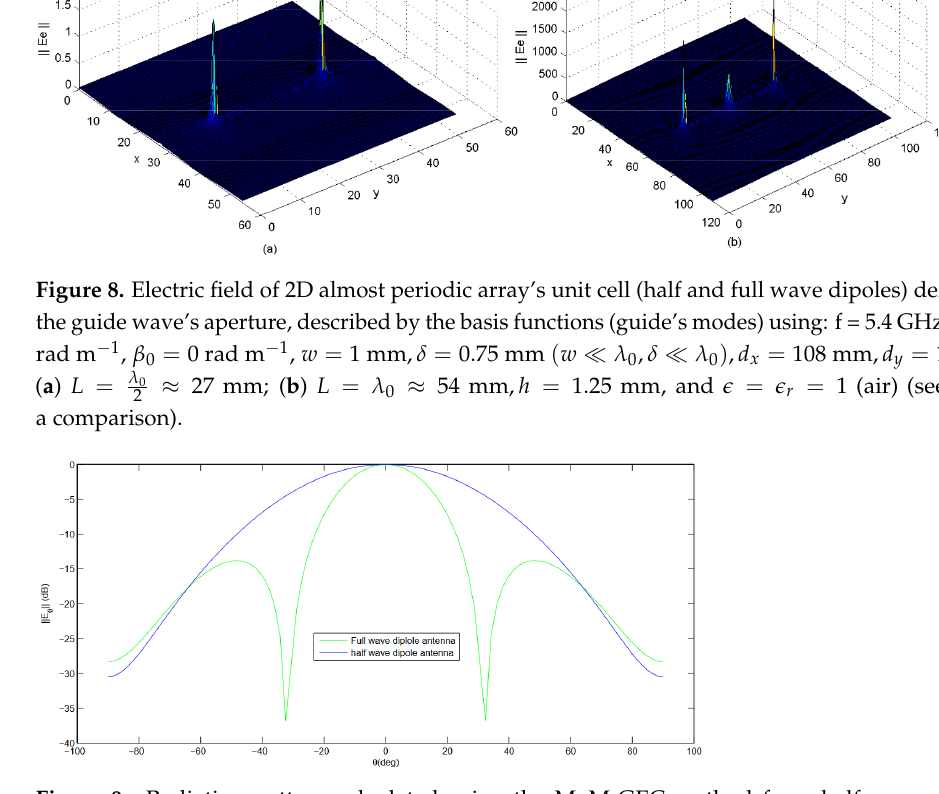
≈ 27 mm; ( Green color ) 2